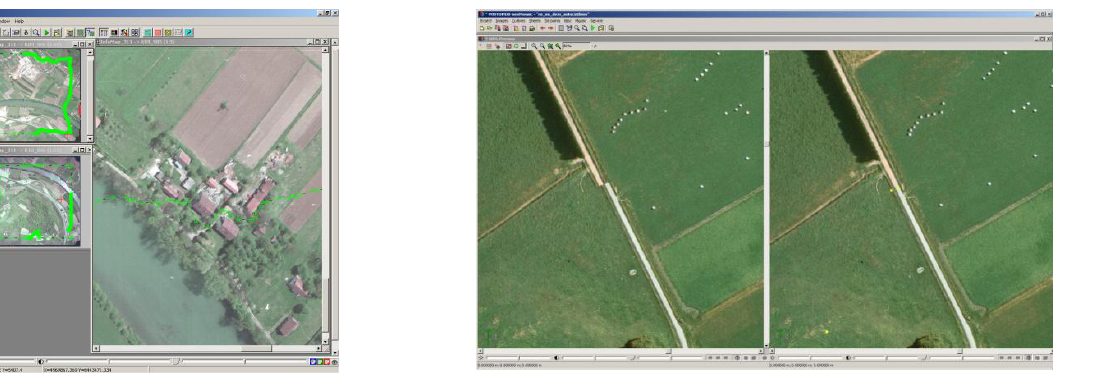
Figure 6. Automatic cut lines creation If the images contain clouds a special module is used for their automatic detection. This algorithm includes a successive filtering of pixels – by intensity, deviation from the grey color, dispersion and heterogeneity. The last function measures the difference between changing of intensity along each axis and its variation. At the last step the remaining pixels are composed in components and their boundaries are calculated as polygons.